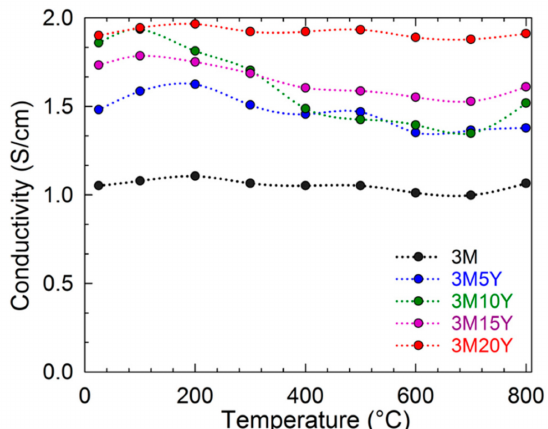
Figure 6. Direct current (DC) conductivity as a function of temperature of dense composites measured by the four-probe method. The electrical conductivity was measured in dry synthetic air. Lines are a guide for the eye.